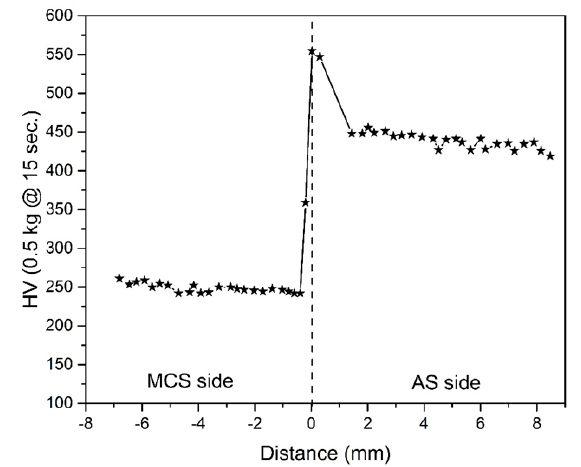
Figure 9: Microhardness variation across the dissimilar joint.